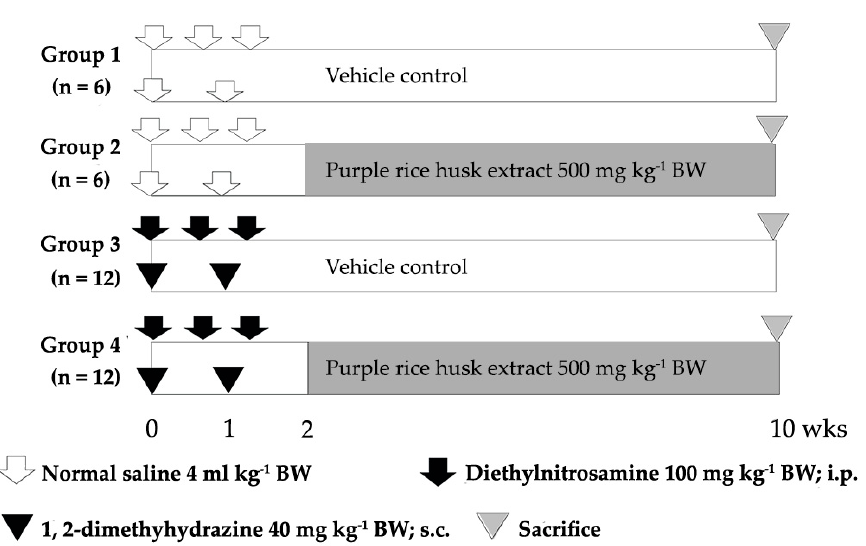
Figure 5. The protocol for the study of the chemopreventive effect of purple rice husk extract on the DEN- and DMH-induced promotion stage of carcinogenesis in rats.